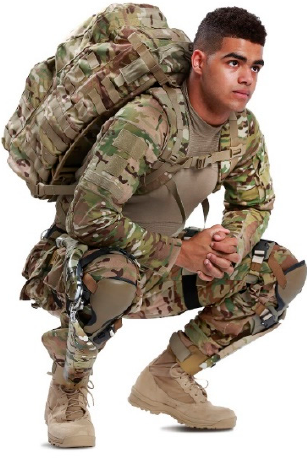
Figure 11. PowerWalk ® knee energy harvester [59].